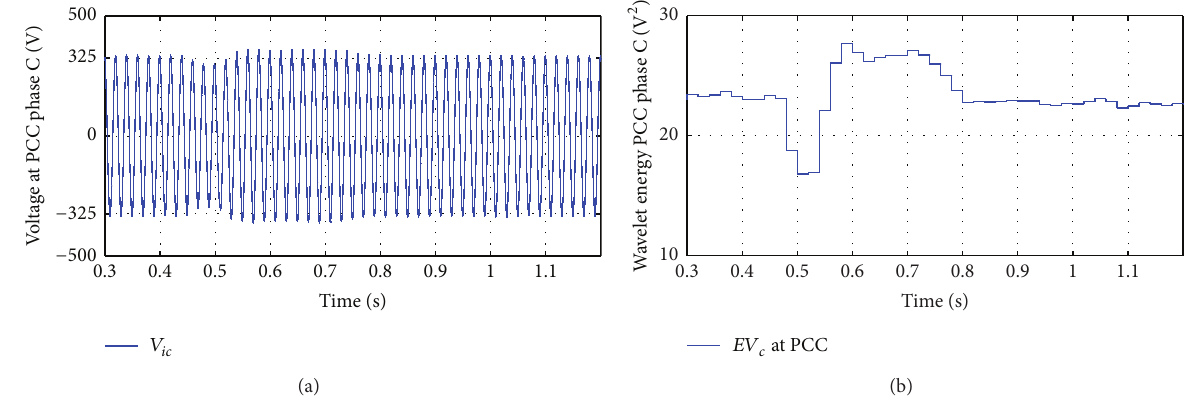
Figure 21: (a) Voltage signal and (b) wavelet energy plot at PCC for phase